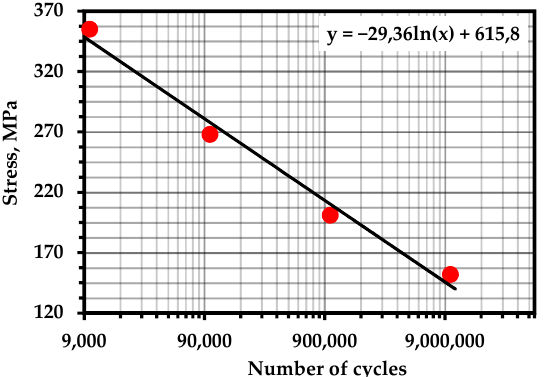
Figure A7. S–N Curve—Steel AISI 1060 (Temperature—293 K; frequency—30 Hz; R = − 1) [102].